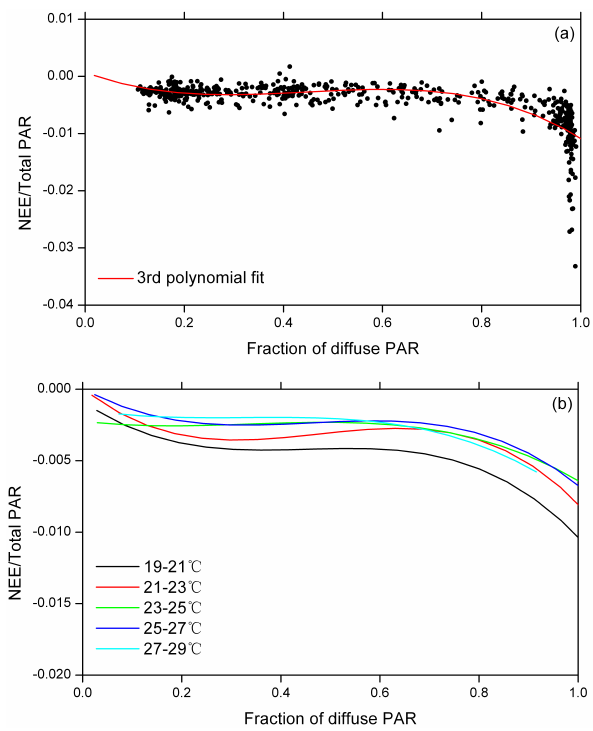
Fig. 5. Light use efficiency of vegetation as a function of the fraction of diffuse PAR for all the data (a) and the air tempera- ture at 2m of 19–21 ◦ , 21–23 ◦ , 23–25 ◦ , 25–27 ◦ and 27–29 ◦ in- tervals (b) . 3rd polynomial fits (a) n = 540, r 2 = 0 . 55, p < 0 . 01; (b) n = 85, r 2 = 0 . 40, p < 0 . 01; n = 127, r 2 = 0 . 66, p < 0 . 01; n = 118, r 2 = 0 . 38, p < 0 . 01; n = 88, r 2 = 0 . 45, p < 0 . 01; n = 34, r 2 = 0 . 24, p < 0 . 01 are